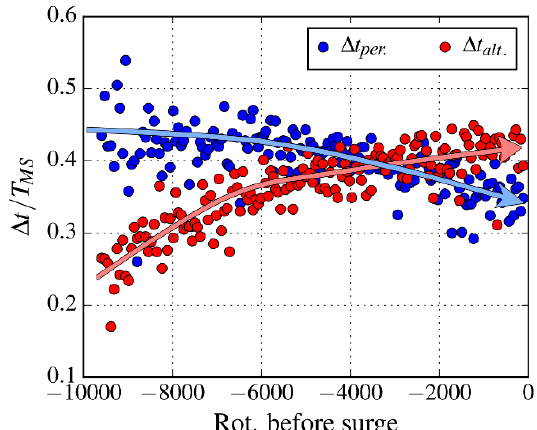
Figure 11. Time evolution of the periodic and alternate phases of mild surge during throttling .